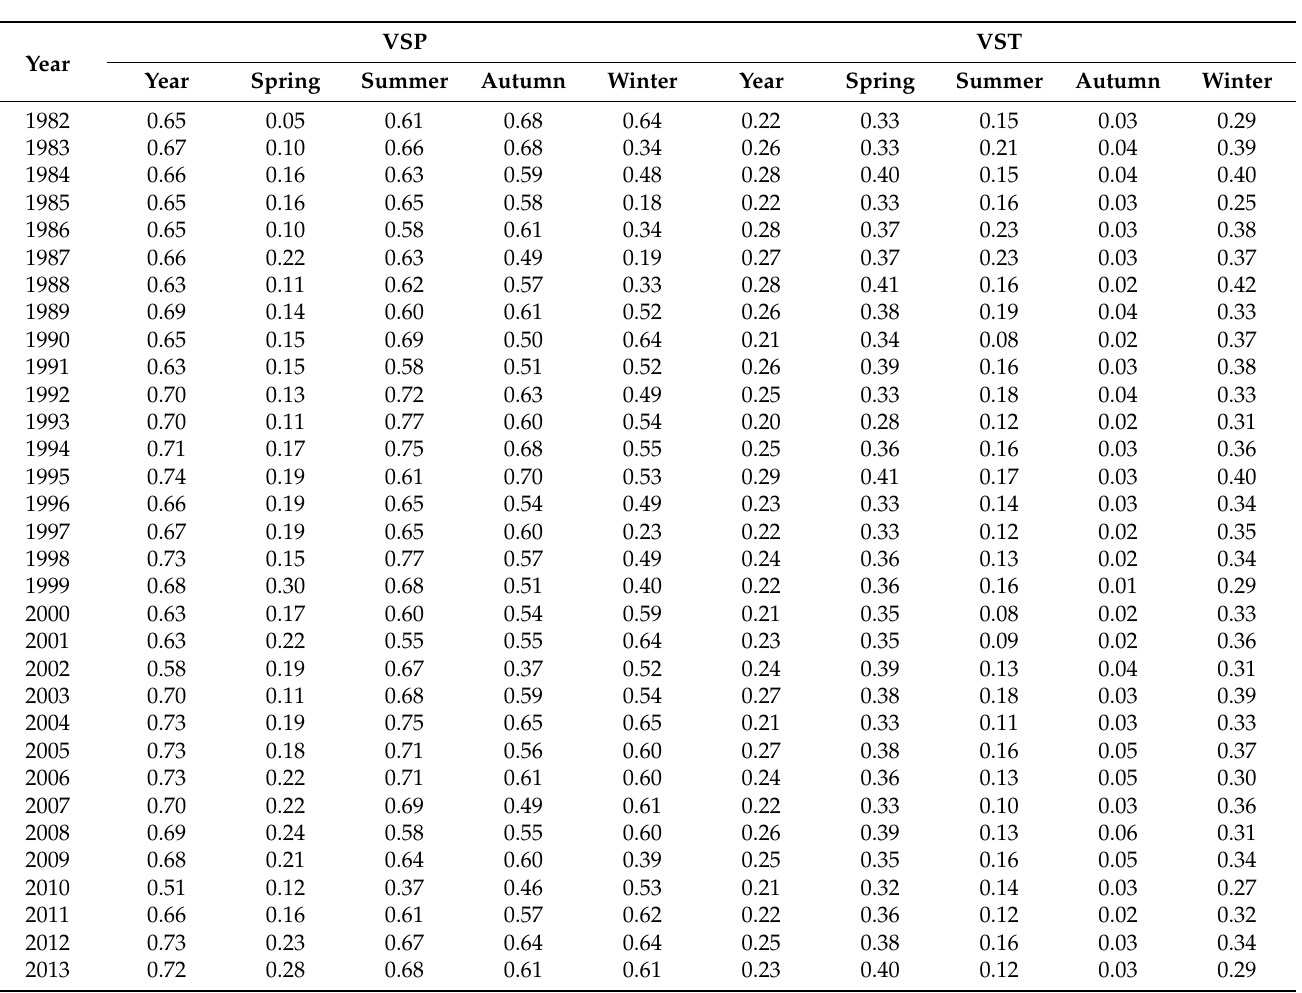
Table 1. Summary information of VSP and VST during 1982-2013 by annual mean, spring, summer, autumn, and winter.